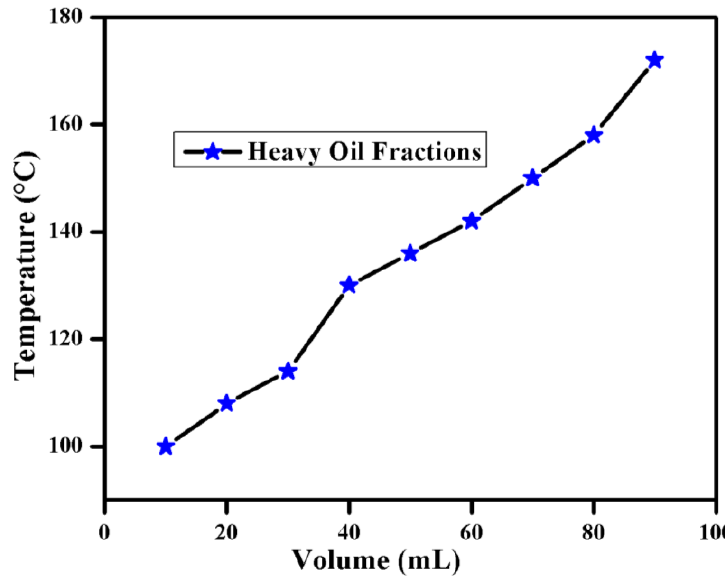
Figure 4. Distillation of Light Oil Fraction.